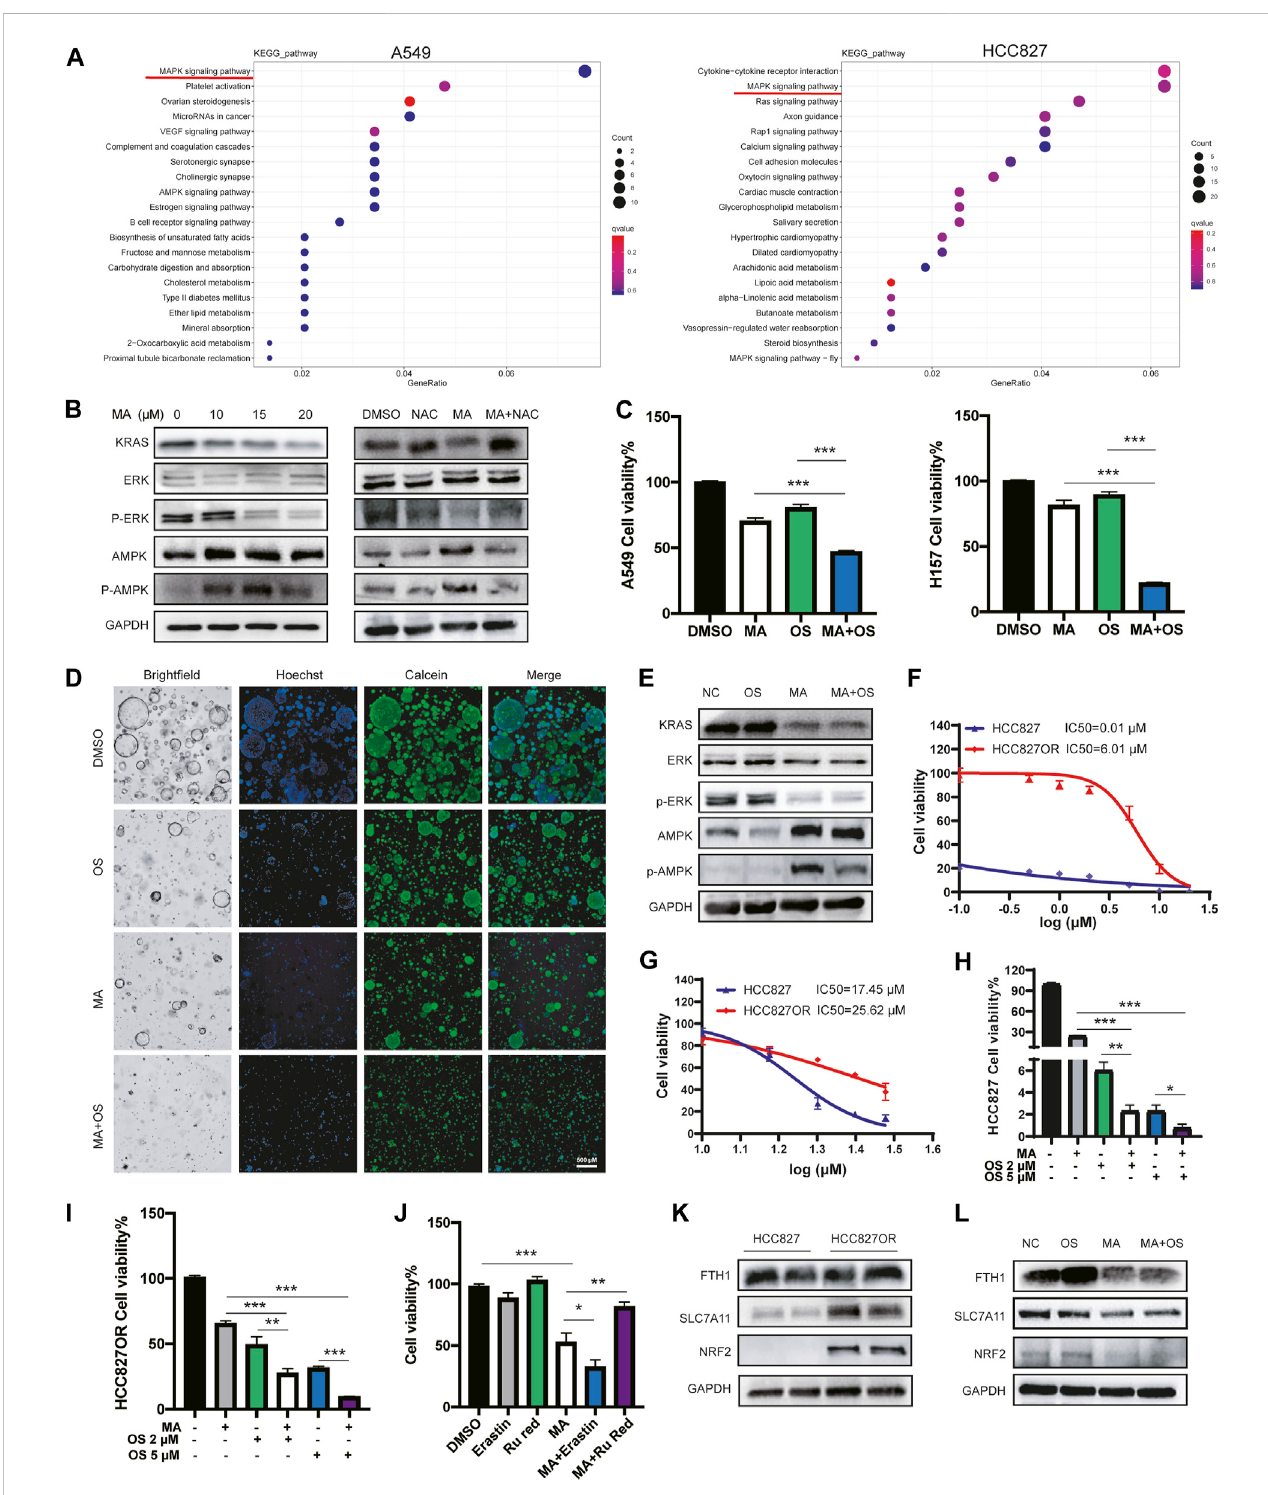
FIGURE 6 The combination of MA and osimertinib inhibits EGFR-TKI resistance in lung cancer cells. (A) Heatmap of KEGG pathway enrichment analyses in A549 and HCC827 cells. (B) The expression of p-ERK/ERK, p-AMPK/AMPK, and KRAS in A549 cells treated with MA and NAC (1 mM). (C) Cell viability of A549 and H157 cells treated with MA (10 μ M) and osimertinib (1 μ M). (D) Cell viability of organoids treated with MA (15 μ M) and osimertinib (2 μ M). (E) The expression of p-ERK/ERK, p-AMPK/AMPK, and KRAS in A549 cells treated with MA (15 μ M) and osimertinib (2 μ M). Viability of HCC827 and HCC827OR cells treated with different concentrations of osimertinib (F) or MA (G) . Viability of HCC827 (H) and HCC827OR (I) cells treated with MA (10 μ M) and osimertinib. (J) CellviabilityofHCC827ORcellstreatedwithMA(15 μ M),erastin(1 μ M),andRuRed(1.5 μ M). (K) TheabundanceofFTH1,SLC7A11,andNRF2in HCC827 and HCC827OR cells. (L) The expression of FTH1, SLC7A11, and NRF2 in HCC827OR cells treated with MA (15 μ M) and osimertinib (2 μ M). * p < .05, ** p < .01, *** p <